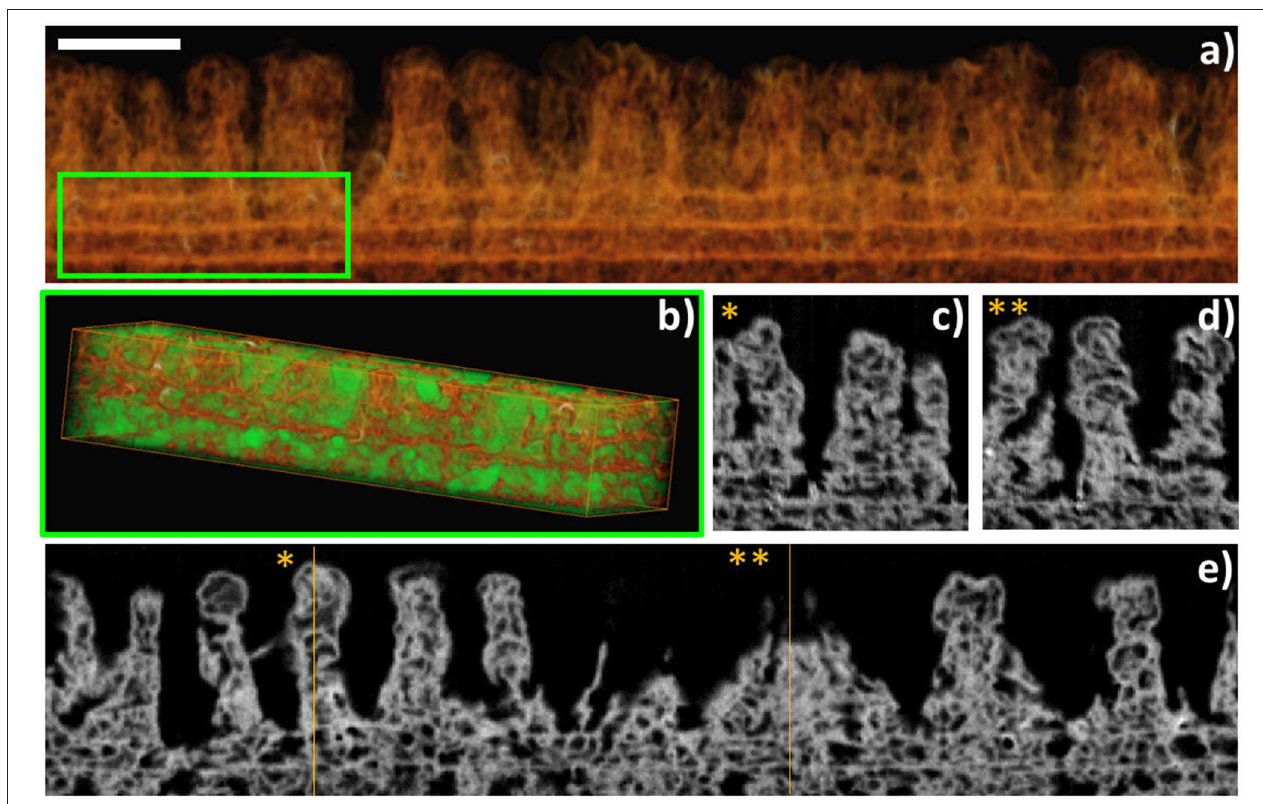
FIGURE 5 | FIB-3D of a sample fabricated using RPAVD-O 2 and soft plasma etching of ClTiPc. (a) Voxel rendering of the 3D reconstruction. (b) A subvolume was selected [inset in (a) ] for the segmentation of the pores (displayed in green) and the porosity estimation. ( e ) is an xy slice through the volume. (c,d) are xz slices at the y positions * and ** indicated in (e) . Scalebar: 500